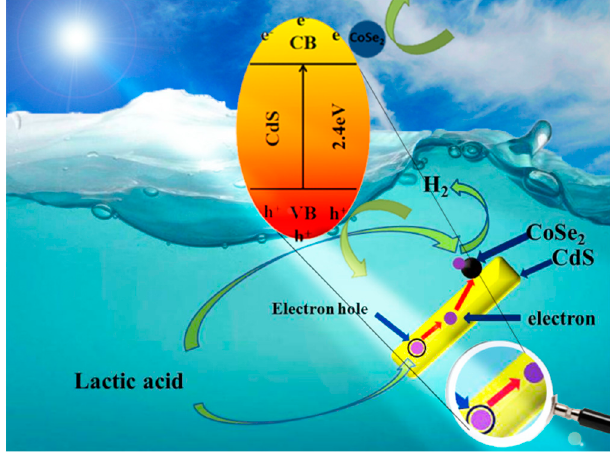
Figure 9. The mechanism of the CoSe 2 / CdS hydrogen evolution system.